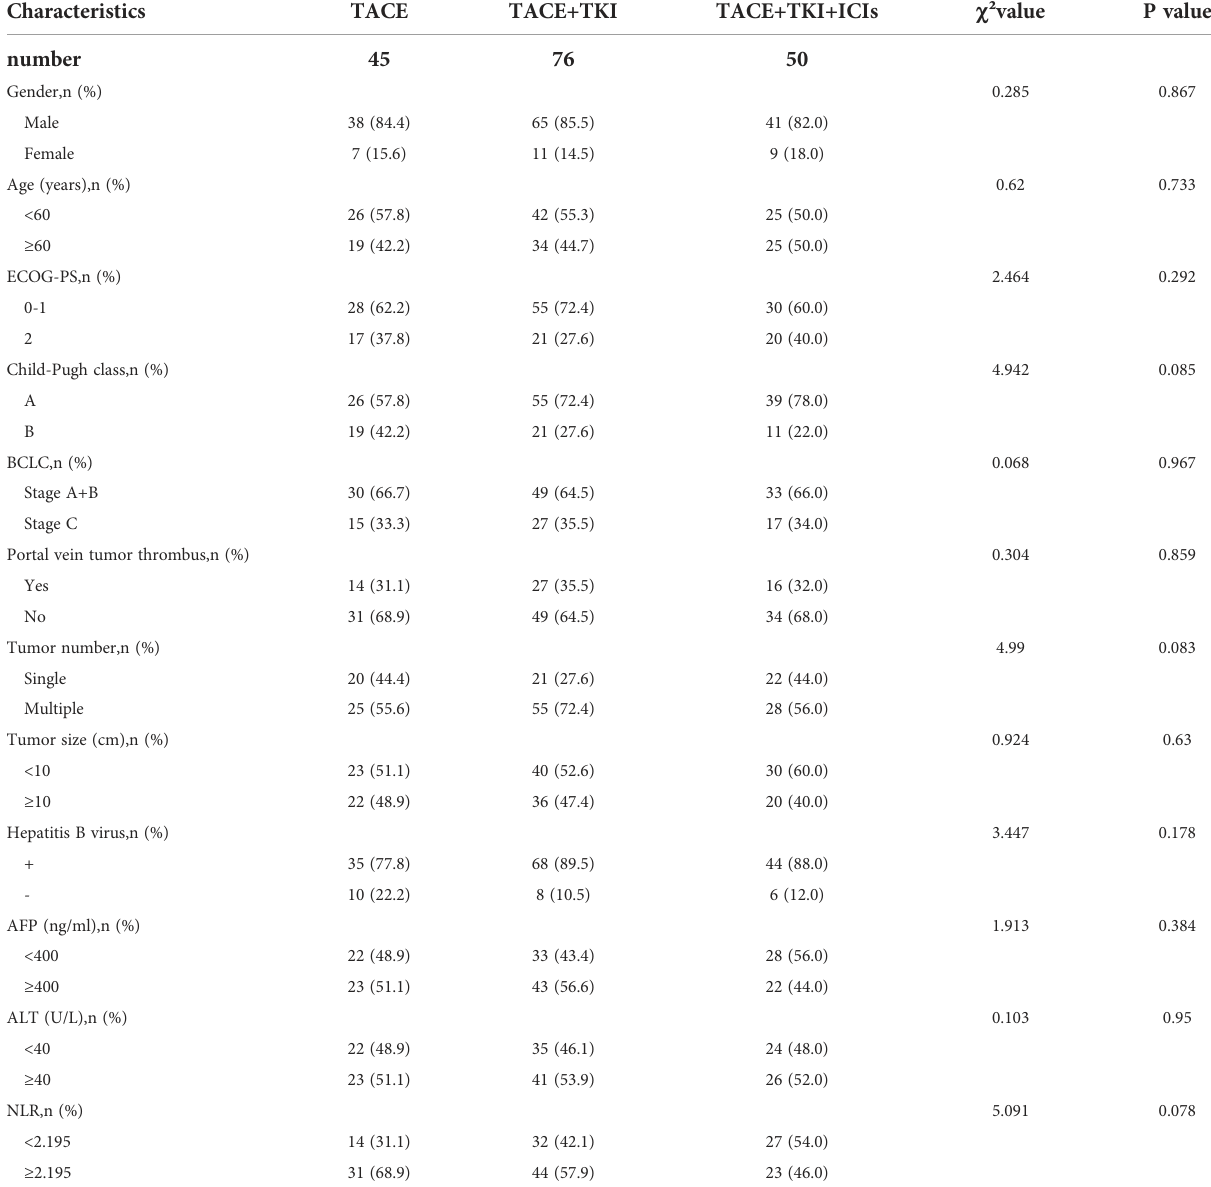
TABLE 1 Baseline data of patients included in the